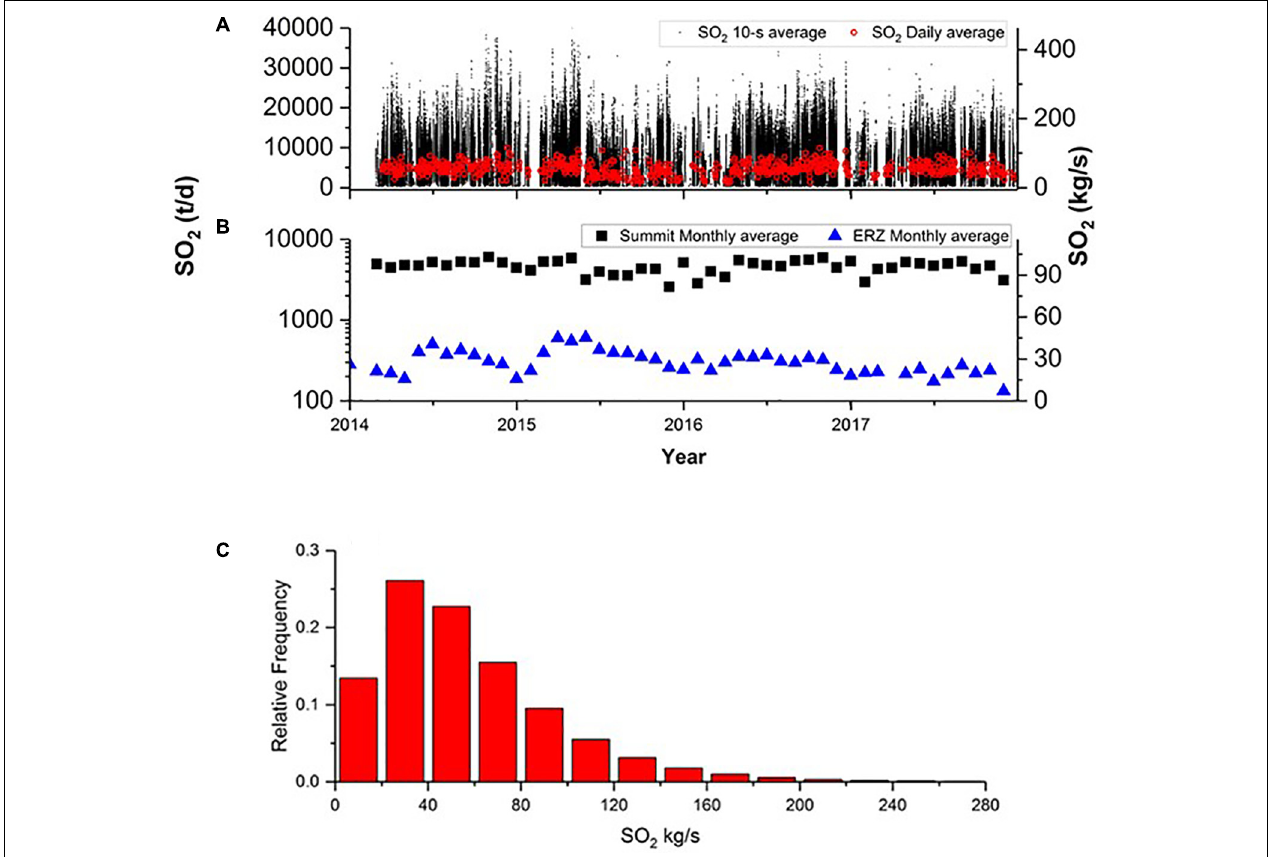
FIGURE 5 | (A) SO 2 10-s (black dots) and daily (red circles) average emission rate time series from K¯ılauea Volcano summit array measurements 2014–2017. Daily means are reported for days with at least 2 h of data. For display purposes, infrequent values ( < 0.5% of data) above 40000 t/d are not shown. (B) Average SO 2 release over a month (black square) was calculated using all valid 10-s values during the period. East Rift Zone average monthly SO 2 (blue triangles) were measured by vehicle traverse of Chain of Craters Road downwind of the Pu‘u ‘ ¯O‘¯o vent ( Figure 2 ). (C) Frequency distribution of summit array 10-s emission rate values show that 99% of the values are less than 200 kg/s ( ∼ 17,000 t/d), with emission rates most commonly between 20 and 60